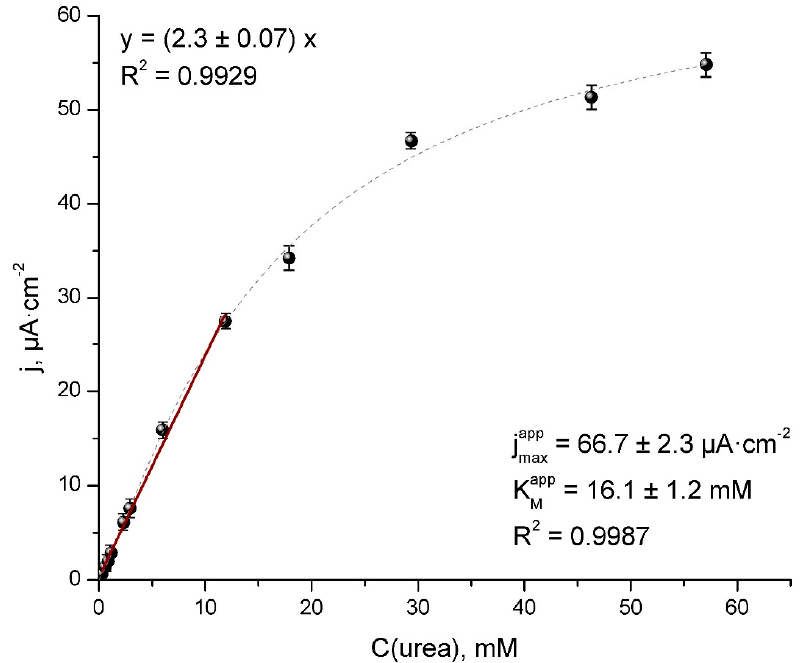
Figure 4. Calibration curve and linear range (black line) for urea obtained using amperometric TRGO-based urea biosensor at 0.2 V vs. Ag / AgCl in 0.02 M of PBS containing 0.1M of KCl.